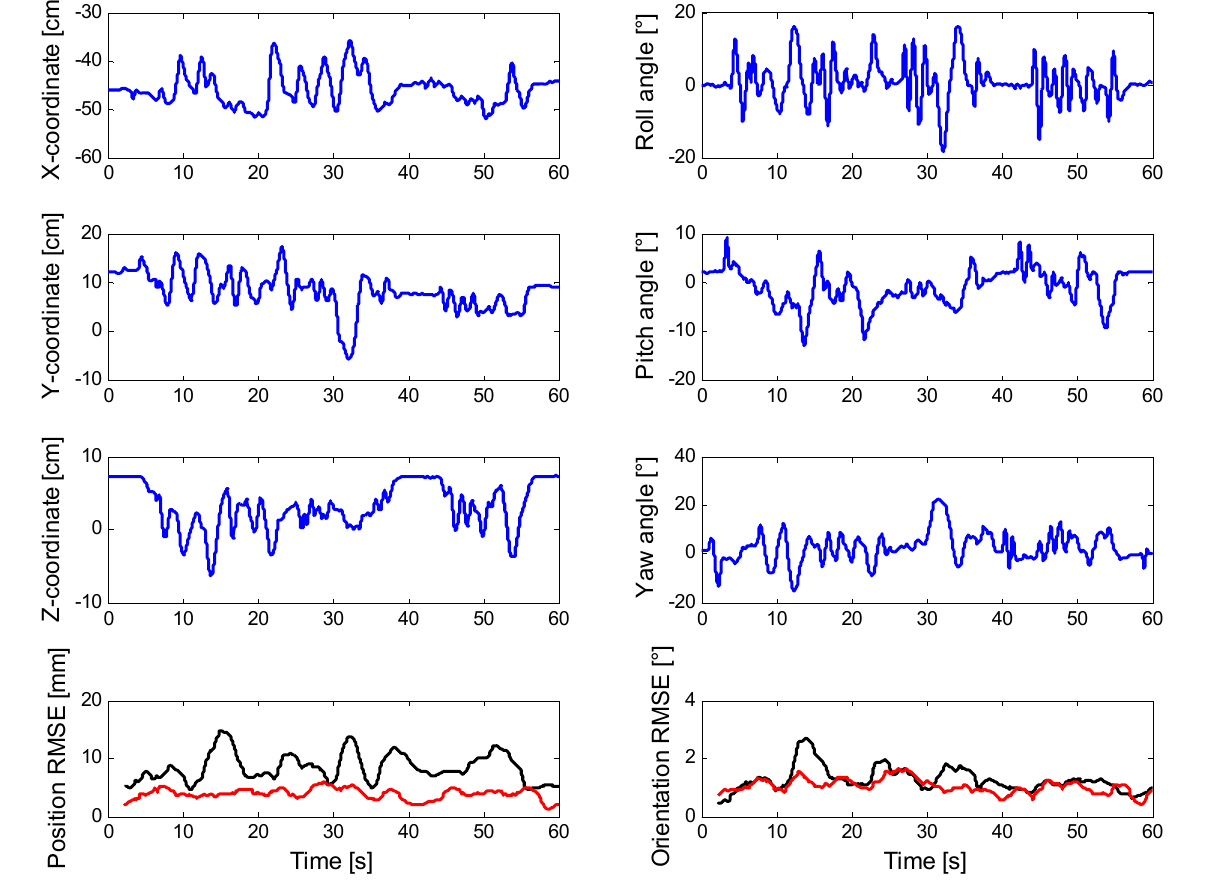
Figure 5. For one of the eight tracking experiments, plots of reference position and Euler angles of the body pose, together with plots of the position and orientation RMSE. For the sake of visualization, the RMSE values are computed over moving average windows of duration 5 s (DLT-based EKF, in red; error-driven EKF, in